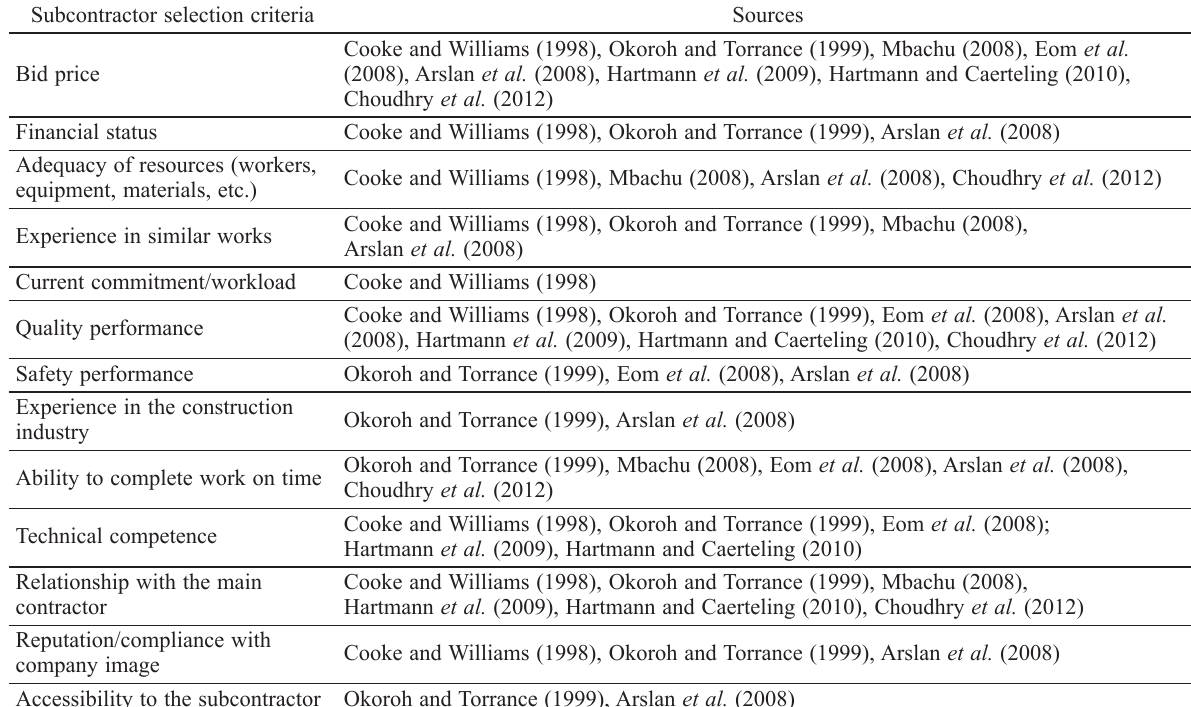
Table 1. The most frequently cited subcontractor selection criteria Subcontractor selection